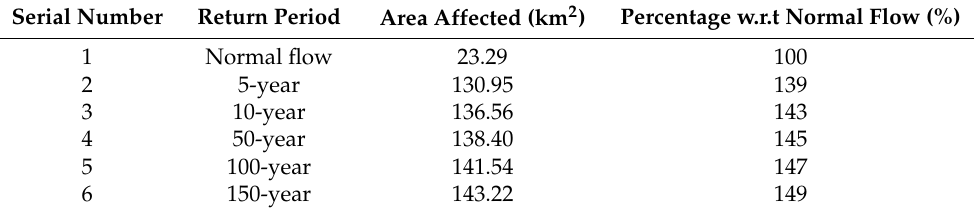
Table 6. Percentage of the surface area flooded during floods of different return